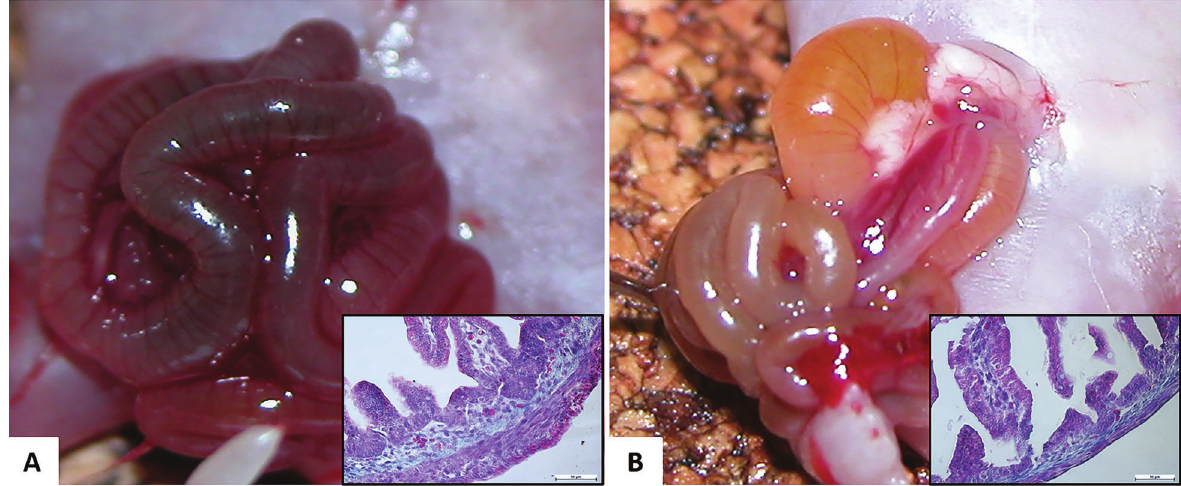
Figure 1. A , Macroscopic view of the intestinal evisceration of the gastroschisis (G) group (time of harvest). Inset: histological representation of ileum specimen stained with H&E of the G group. B , Macroscopic view of the intestinal evisceration of the gastroschisis + cannabidiol (GCBD) group (time of harvest). Inset: histological representation of the ileum specimen stained with H&E of the GCBD group. Note the different aspect and thickness of the bowel loop macroscopically and microscopically between the 2 groups. Masson ’ s trichrome staining from ileum segment. Magni fi cation: 100 (cid:1) . Scale bar: 10 m m.